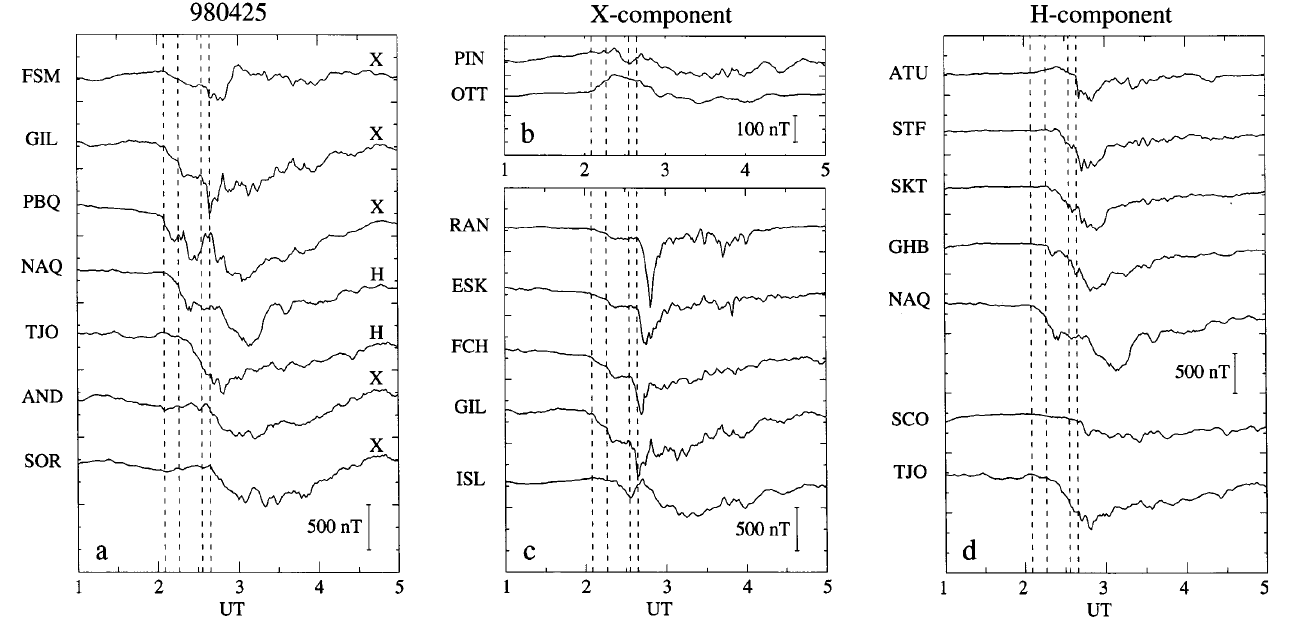
premidnight sector. d Magnetograms from the Greenland/Iceland chains in the midnight and postmidnight sectors. The vertical lines indicate 0205, 0216, 0232, and